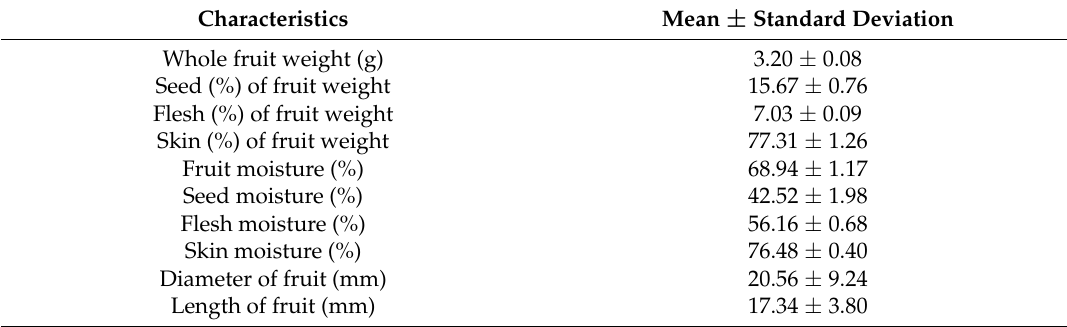
Table 1. Physical characteristics of the Tuckeroo